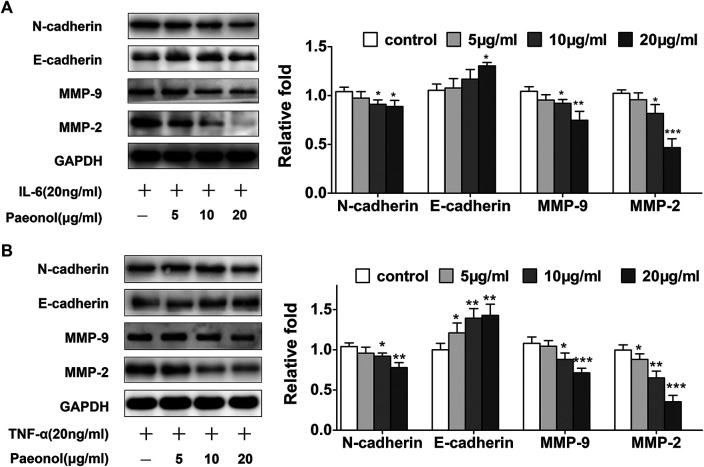
Paeonol inhibits EMT and modulates MMPs system in A549 cells stimulated with TNF-α or IL-6. A549 cells were treated with paeonol at indicated concentrations and/or TNF-α (20 ng/ml) or IL-6 (20 ng/ml) for 24 h (A,B) Western blot analyses of N-cadherin, E-cadherin, MMP-9 and MMP-2 with quantification. GAPDH was used as an invariant control for equal loading and representative blots were from three independent experiments (n = 3). Significance: *p < 0.05 vs. control, **p < 0.01 vs. control, ***p < 0.001 vs. control.